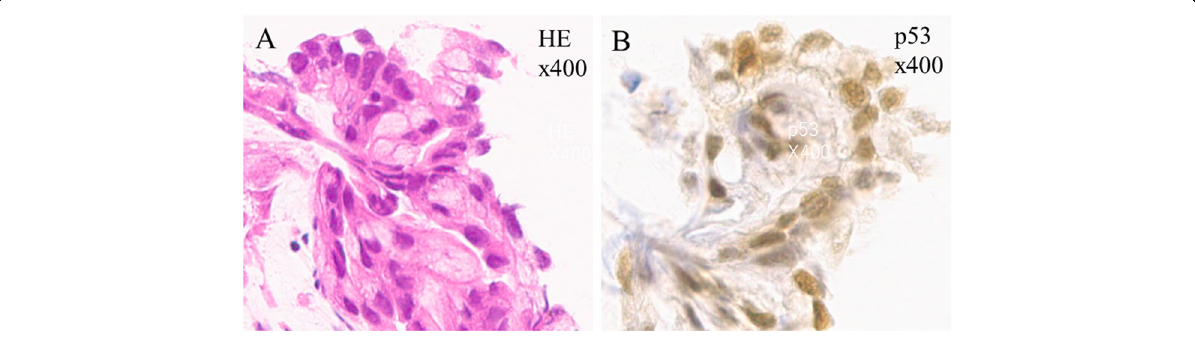
Fig. 4 a Hematoxylin-eosin (HE) staining. Pathological assessment of the tumor specimens obtained by endoscopic biopsy reveal